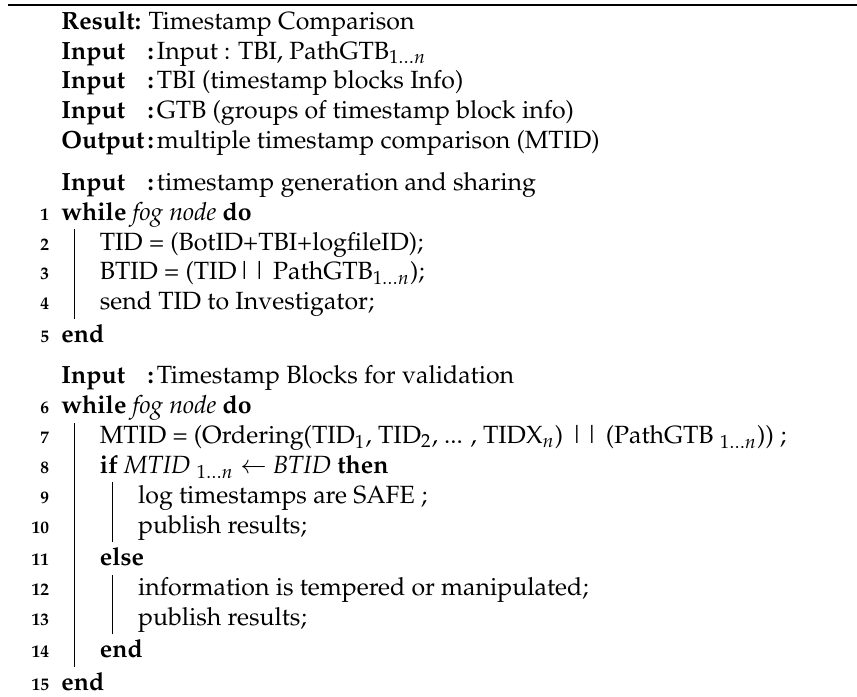
Algorithm 1: Log Validation Algorithm (LVA) Result: Timestamp